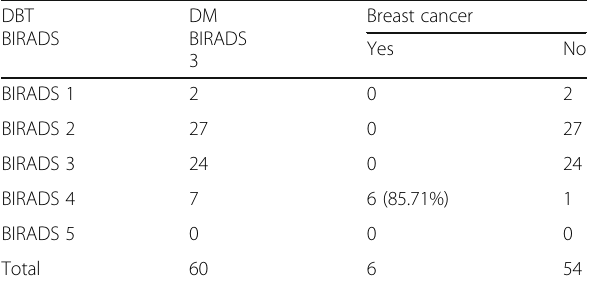
Table 5 BIRADS 3 lesions following DBT and breast cancer